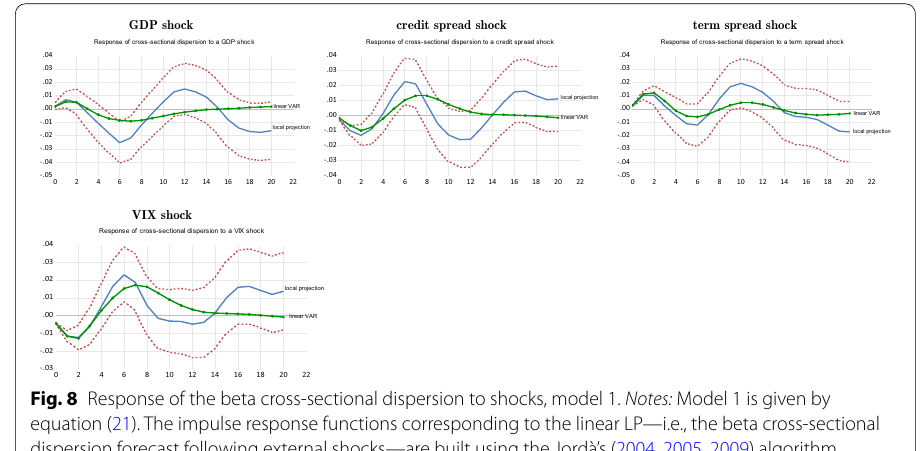
Fig. 8 Response of the beta cross‑sectional dispersion to shocks, model 1. Notes: Model 1 is given by equation (21). The impulse response functions corresponding to the linear LP—i.e., the beta cross‑sectional dispersion forecast following external shocks—are built using the Jordà’s (2004, 2005, 2009) algorithm provided by Eren Ocakverdi, consultant at Yapy Kredi. The local projection of the beta cross‑sectional dispersion is performed over the subprime crisis (2007Q3–2009Q4). We also provide the linear VAR estimated over the whole sample period selected as benchmark. The confidence interval of the LP impulses, computed at the threshold of 95%, is in dotted